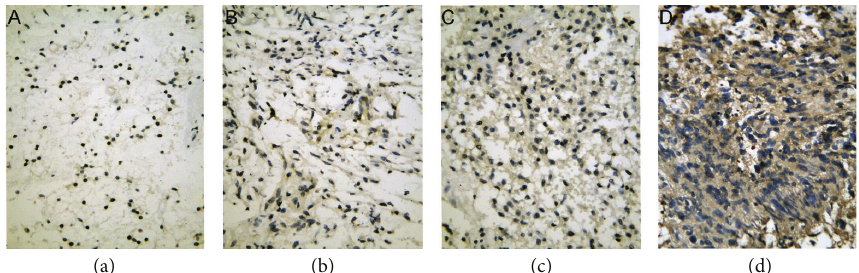
Figure 2: Relationship between DcR3 expression and the grade of glioma: (a) grade I, (b) grade II, (c) grade III, and (d) grade IV ( × 400).